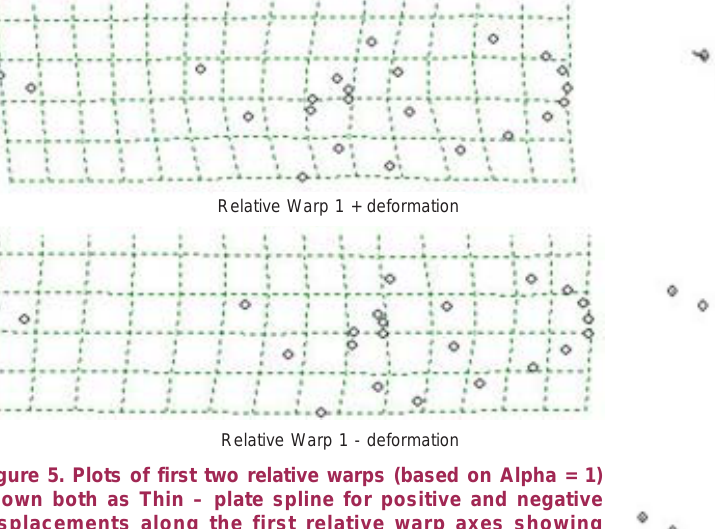
Figure 5. Plots of first two relative warps (based on Alpha = 1) shown both as Thin – plate spline for positive and negative displacements along the first relative warp axes showing the net arrangement of land marks. (Alpha = 1)